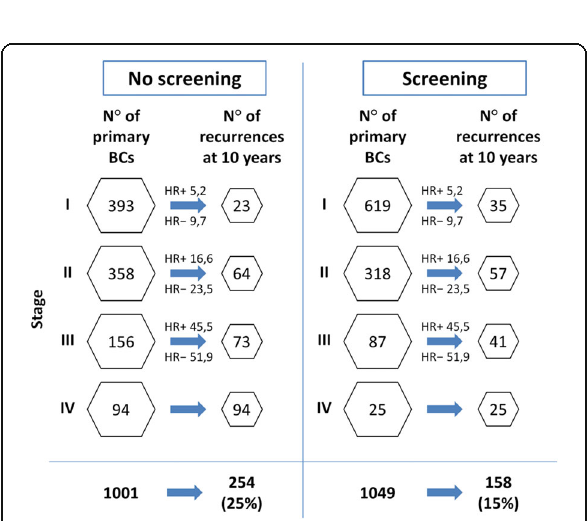
Fig. 3 Effect of screening and novel systemic treatments on breast cancer recurrences among women aged 60 to 74 years, diagnosed with breast cancer between 2000 and 2013. Stage distribution was derived from Puliti et al. [21] considering attenders and non- attenders to screening mammography; a 5% overdiagnosis attributed to screening mammography was taken into account. HR+ and HR − recurrences are back-calculated from Mariotto et al. [24]. The most favourable scenario arises from the use of mammography screening associated with novel systemic treatments. BCs, breast cancers; HR+, hormone receptor-positive breast cancers; HR − , hormone receptor-negative breast cancers